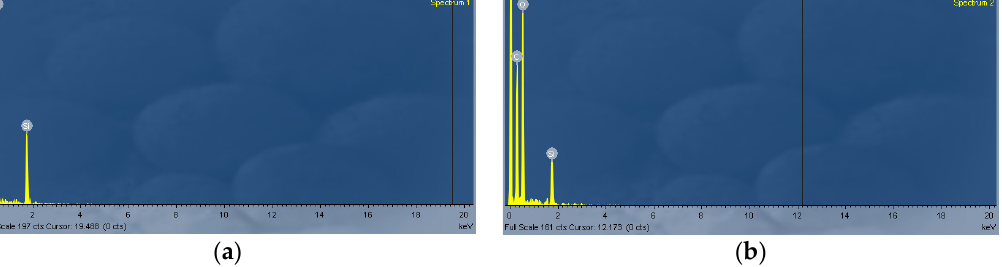
Figure 3. Spectrographic analysis of the surface of ( a ) a naked tapered optical fiber (without any kind of deposit, only silica is present) and ( b ) a GO deposited on a naked taper. A carbon peak associated with graphene appears in this case.